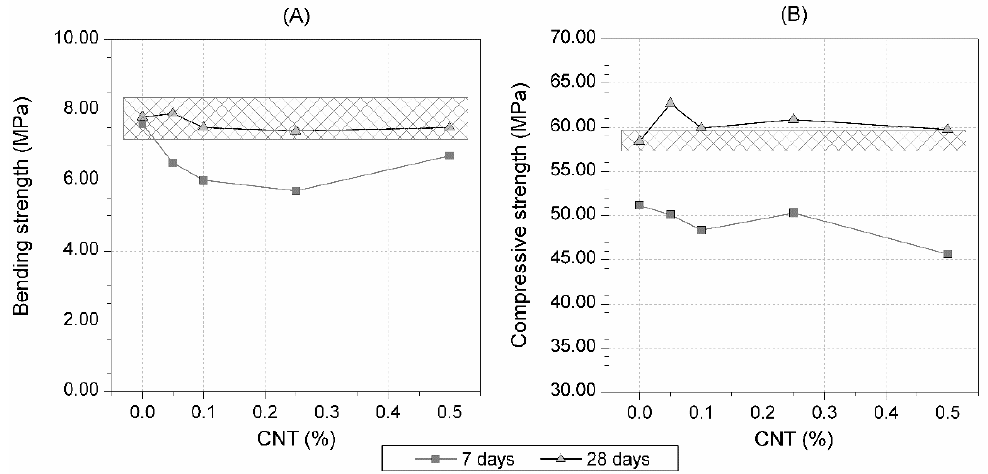
Figure 1. ( A ) Bending strength and ( B ) compressive strength of mortars with different dosages of CNT tested at 7 and 28 days curing time. The hash-marked area represents the confidence interval for the average value of the 28-days reference mortar without CNT, with a confidence level of 95% according to UNE 66040:2003